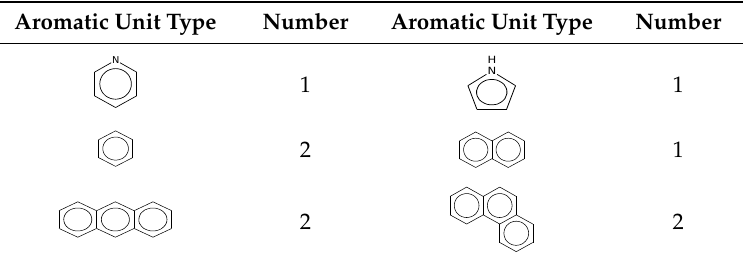
Table 4. The type of aromatic structure in Bulianta coal.